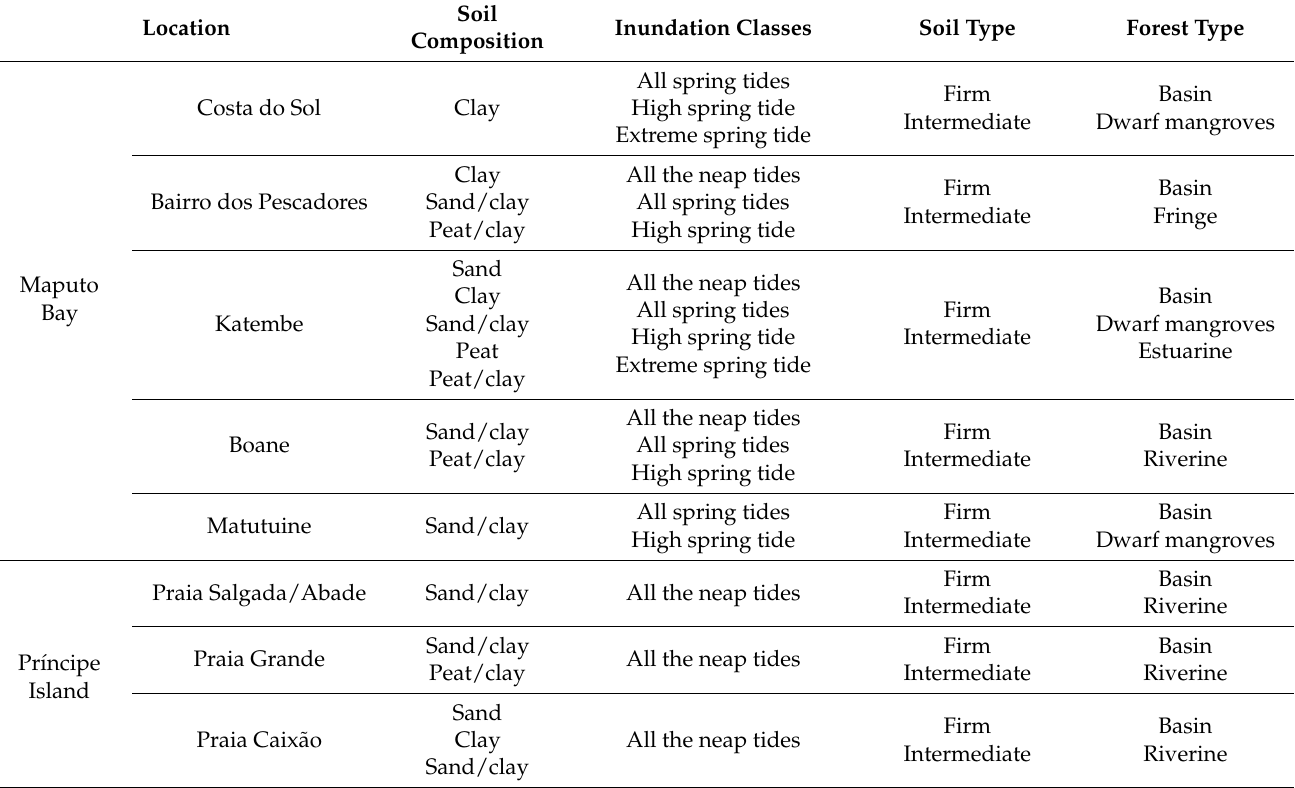
Table 1. Characterization of Maputo Bay and Pr í ncipe Island mangrove sampled